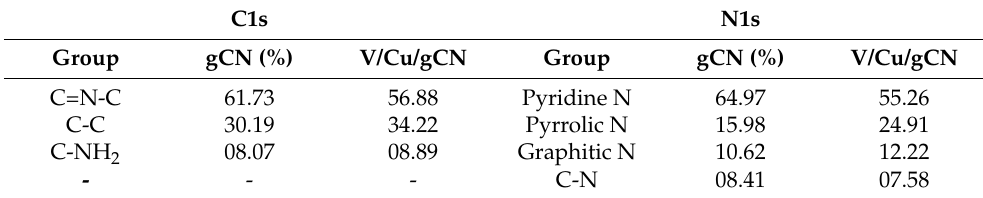
Table 2. C1s and N1s functional group distributions.